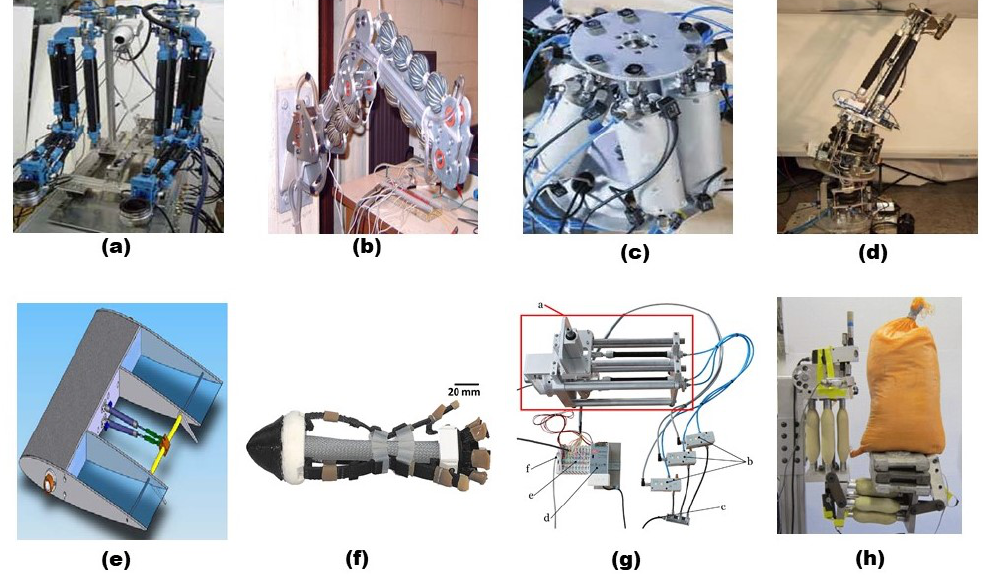
Figure 15. Industrial applications of PAMs: ( a ) PAM-actuated robot arm system [175]; ( b ) 2-DOFs planar robotic manipulator [176]; ( c ) parallel–kinematic hexapod tool [180]; ( d ) hybrid robot [181] ( e ) PAM-activated trailing edge flap [182]; ( f ) Crawling soft robot [184]; ( g ) Compliant pneumatic rotary drive unit [185]; ( h ) Heavy-lift robotic manipulator